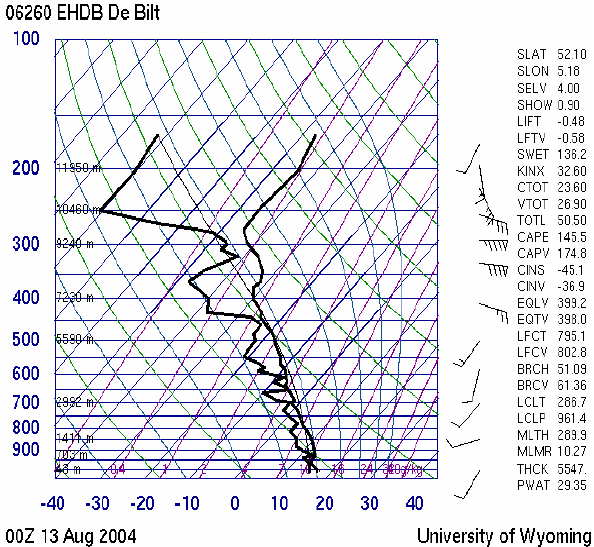
Fig. 5. Skew-T diagram, related to the atmospheric sounding from De Bilt, The Netherlands of 13 August 2004 00:00 UTC. The figure is provided by the University of